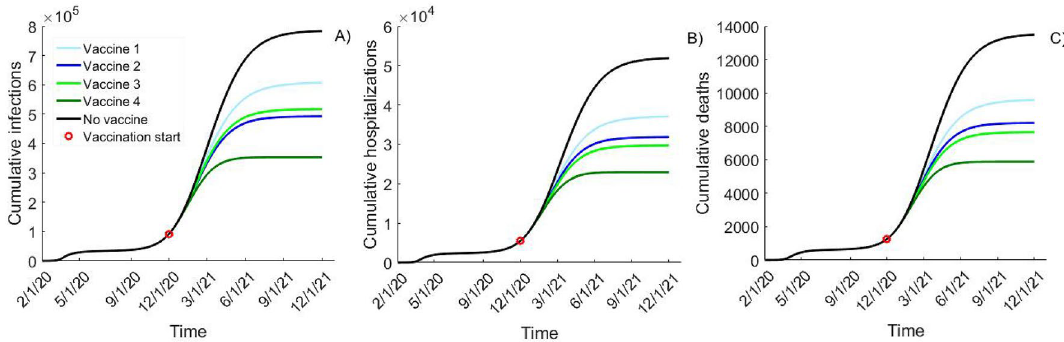
Figure 2. Epidemic projections with different vaccine efficacy profiles. Comparison of ( A ) cumulative infections; ( B ) cumulative hospitalizations and ( C ) cumulative deaths over time simulated with different efficacy profiles assuming vaccination start date of Dec. 1, 2020 and rolled out with 5000 vaccinated daily until 1,000,000 vaccinations are reached. Vaccine 1 (10% VE SUSC and 44.4% VE SYMP ) and Vaccine 2 (40% VE SUSC and 16.7% VE SYMP ) result in 50% reduction in symptomatic disease (VE DIS ) while Vaccine 3 (10% VE SUSC and 88.9% VE SYMP ) and Vaccine 4 (80% VE SUSC and 50% VE SYMP ) result in 90% VE DIS . All projections represent the mean value of epidemic simulations using 100 calibrated parameter